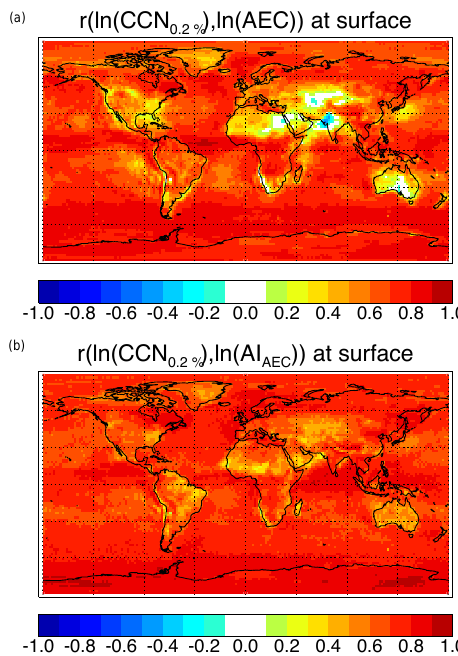
ficients between CCN 0 . 2% at cloud base and AOD below 0.5